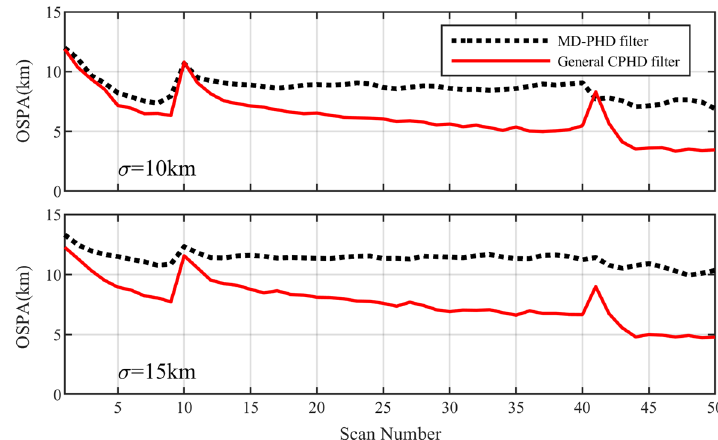
Fig. 11 OSPA metric of the general CPHD filter and the MD-PHD filter for different range